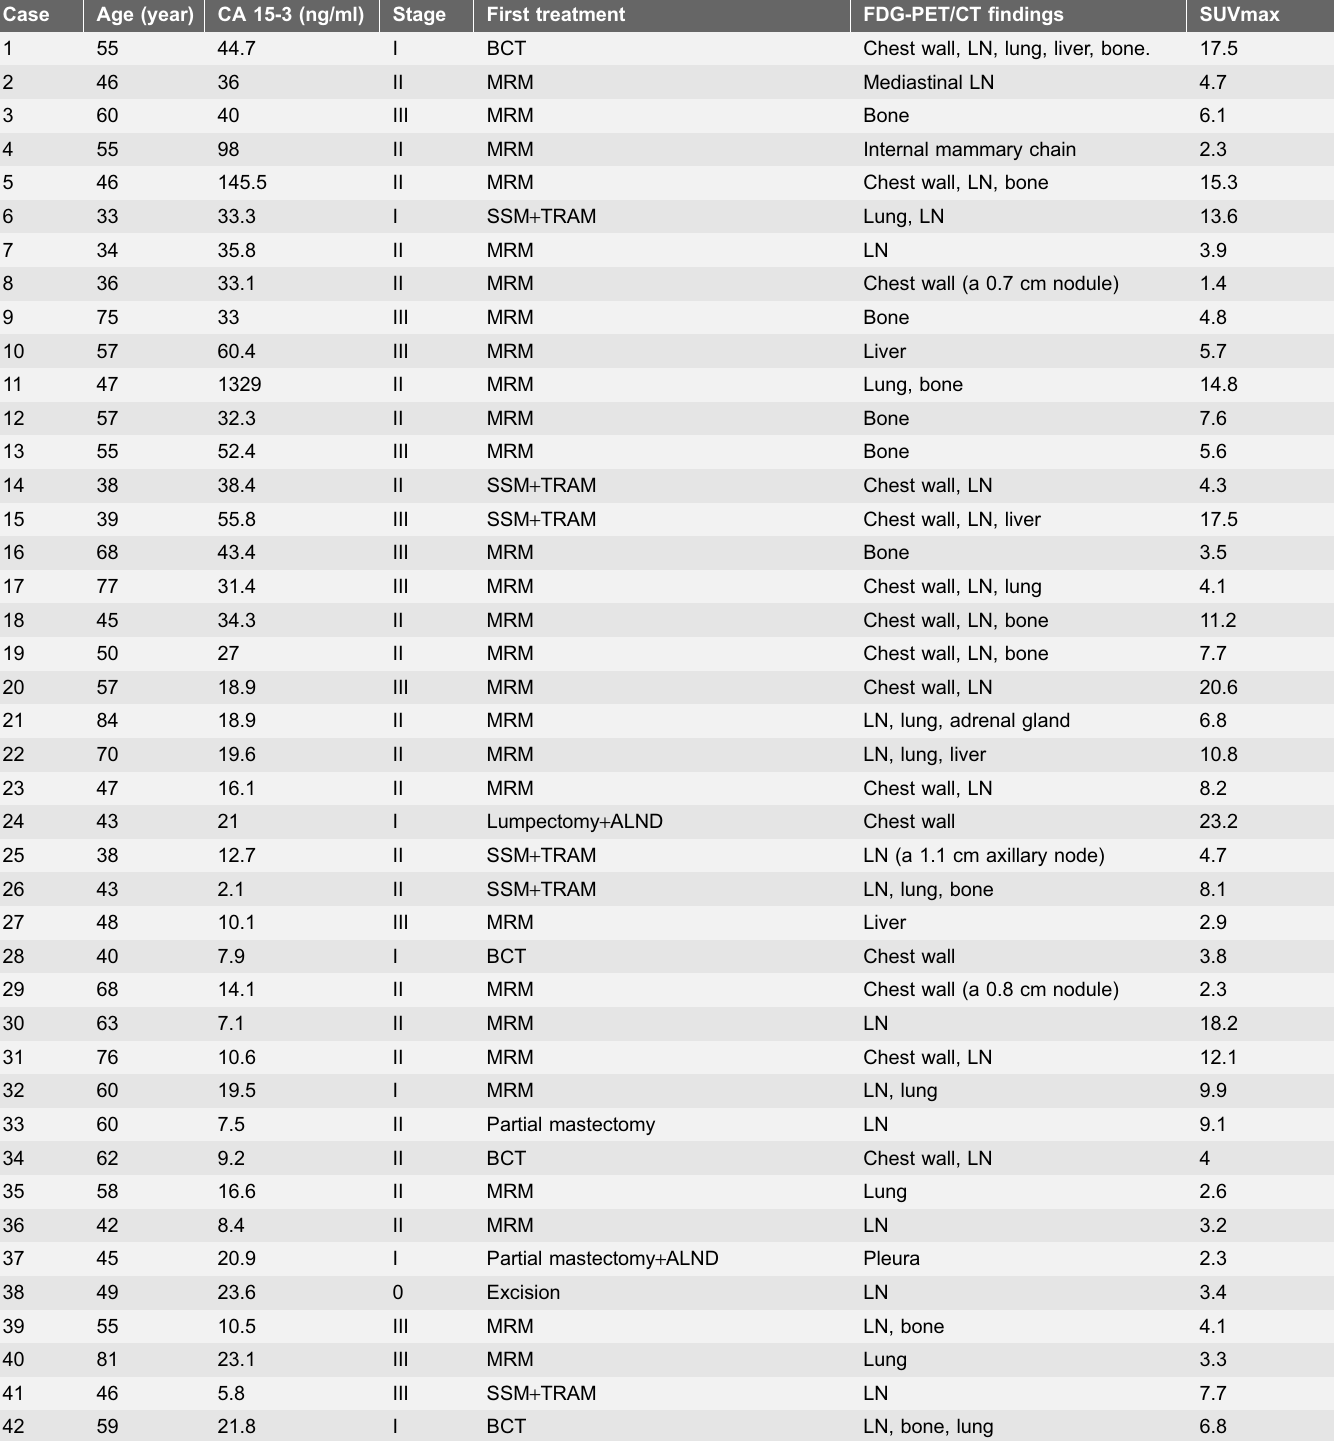
Table 3. Detailed information about the patients with recurrent breast cancers and positive FDG-PET/CT